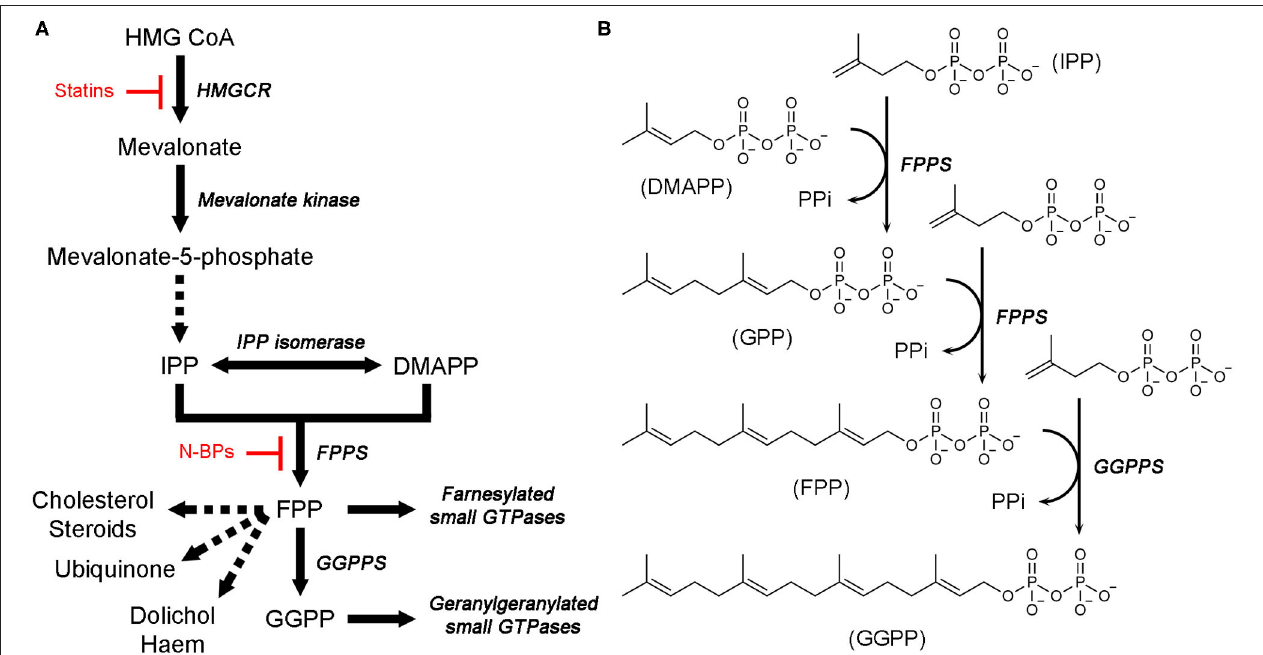
FIGURE 1 | Mevalonate pathway and downstream metabolites. (A) An overview of the MVA pathway and downstream metabolites. Enzyme names are in italics. Dotted arrows represent multiple enzymatic steps. Sites of pharmacological intervention by current clinical drugs are indicated in red. (B) Catalytic steps of FPPS and GGPPS reactions.